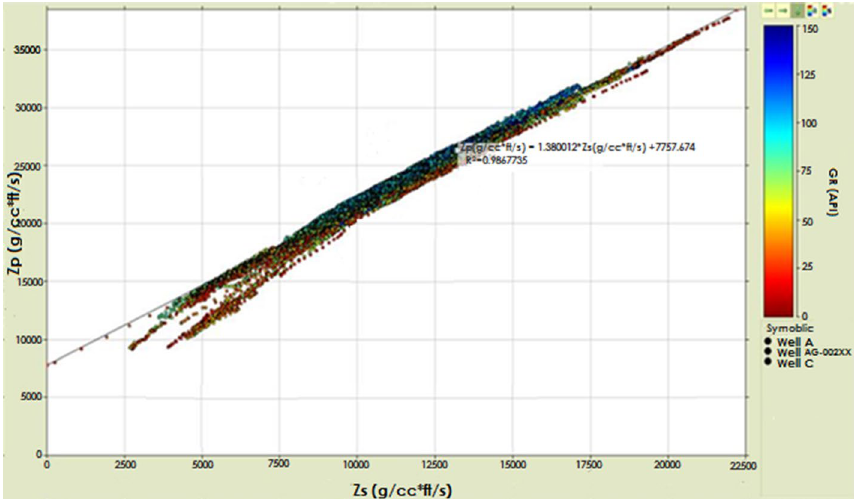
Z p verses s Q n (1.380012